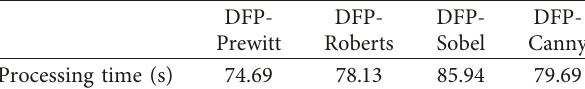
Figure 11: Illustrations of crack detection results of Table 3: Processing time of the models.